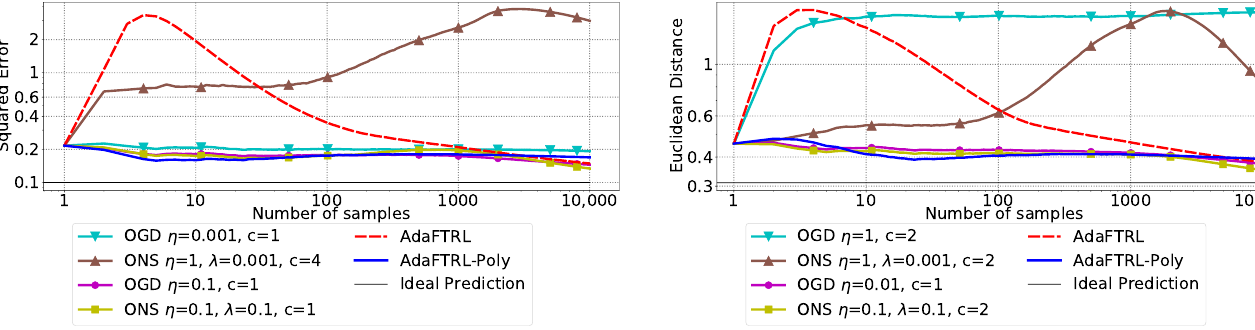
Figure 3. Results for setting 3 (time-varying models), using a combination of stationary ARIMA(5,2,1) and ARIMA(5,2,0)